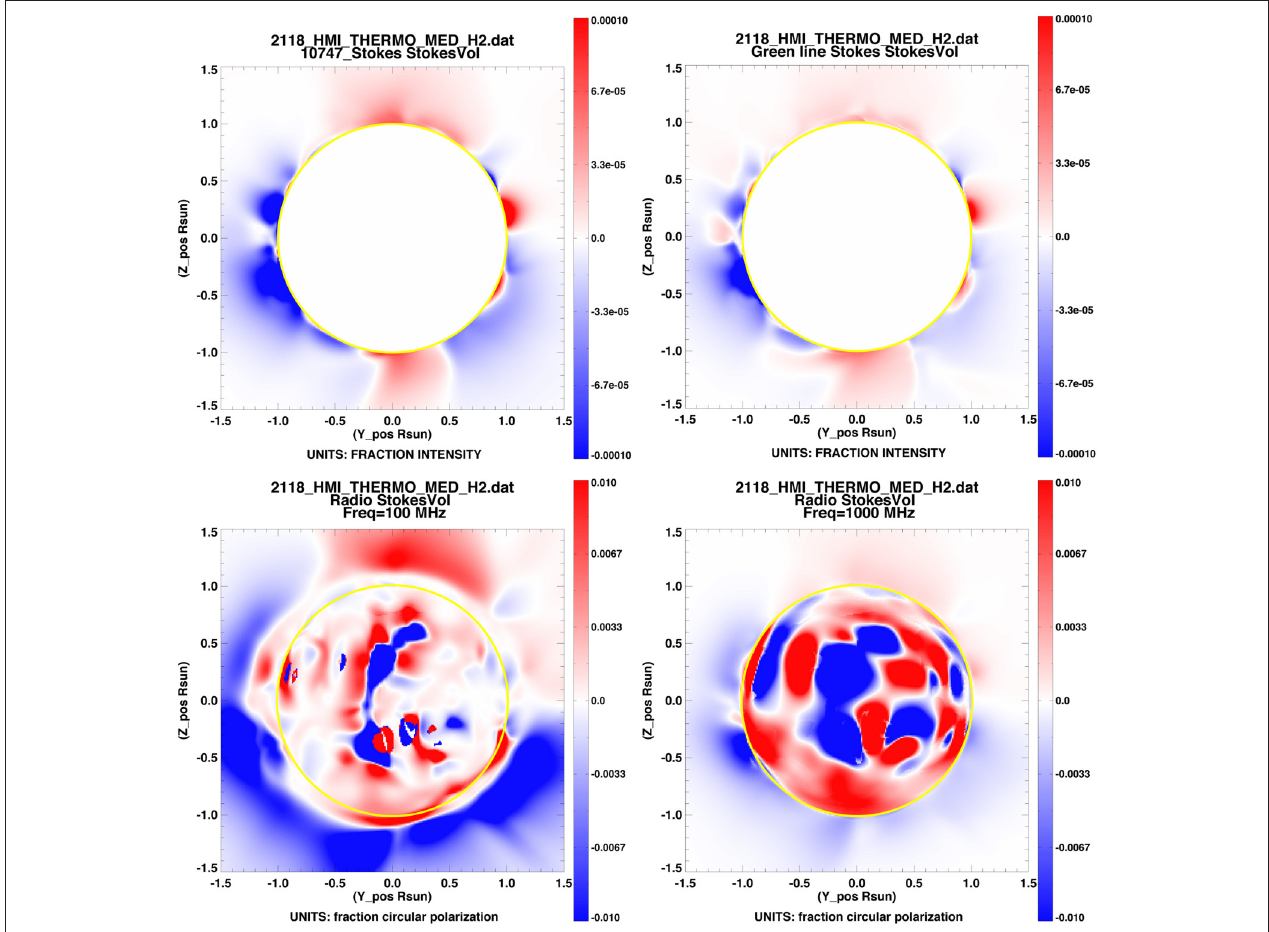
FIGURE 7 | Because of different dependencies on plasma along the line of sight, the representation of integrated circular polarization (dependent upon line-of-sight magnetic field strength) appears differently at different wavelengths. (Top left) MAS model V / I for Fe XIII 1074.7. Plot obtained as in Figure 6 , with additional keywards imin=-0.00001,imax=0.00001 . (Top right) Same for Fe XIV green line. Plot obtained by following the process outlined in Figure 6 , but substituting /greencomp for /comp . (Bottom left) Same for radio bremstrahllung, at a frequency of 100MHz. Plot obtained as in Figure 6 , but with /radio instead of /comp and frequency_MHz=100,imin=-0.001,imax=0.001 . (Bottom right) Same, but substituting frequency_MHz=1000 . Unlike the visible and IR lines, radio frequencies can be observed above the solar disk as well as at the